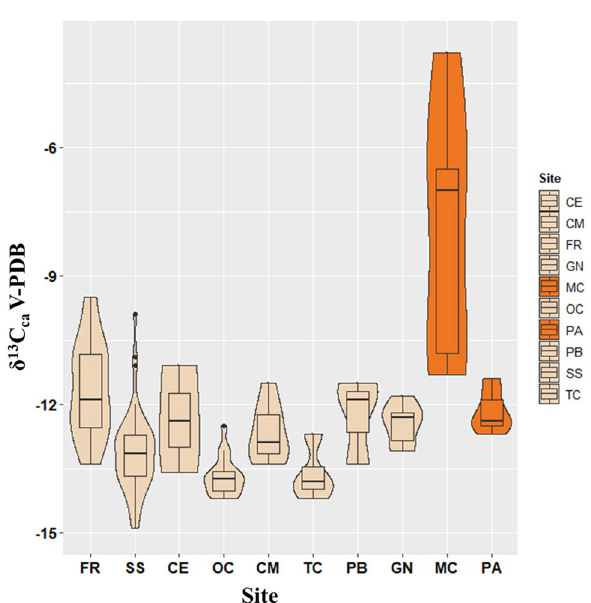
Figure 5. Violin plots for the carbon isotope values (δ 13 C ca ) of the Copper Age (dark-ivory) and Neolithic (orange) populations. The Copper Age and Neolithic sites are arranged from left to right according to decreasing latitude. The top and bottom limits of the embedded boxes indicate the third and the first quartiles, while the middle lines are the Medians. The top and bottom whiskers cover the statistical range for the population, and single dots represent individual outliers. SS = Buca di Spaccasasso; FR = Fontenoce di Recanati; CM = Casetta Mistici, OC = Osteria del Curato-Via Cinquefrondi; TC = Torre della Chiesaccia, PB = Pantano Borghese; GN = Grotta Nisco; CE = Celano Pratovecchio; MC = Mora Cavorso; PA =